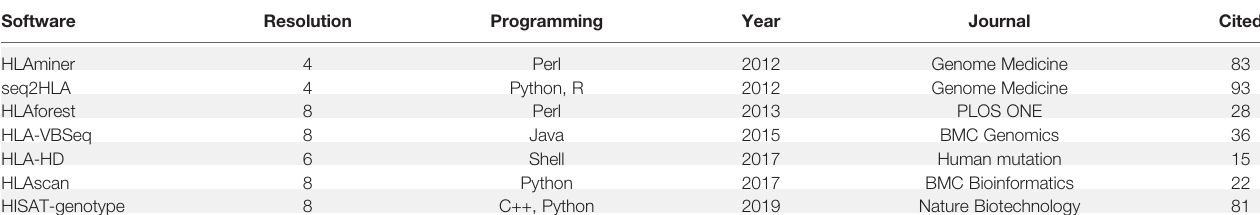
TABLE 1 | HLA-typing software used in this